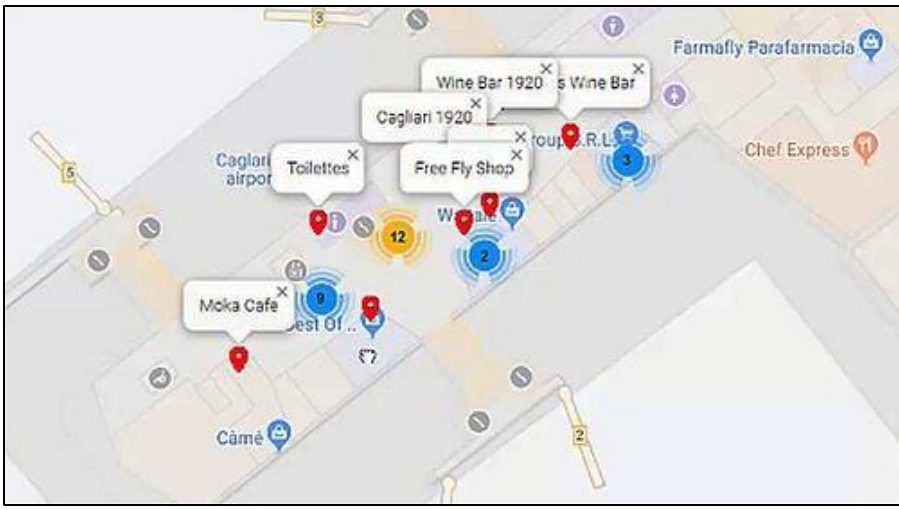
Figure 10. Snapshot of people tracking and